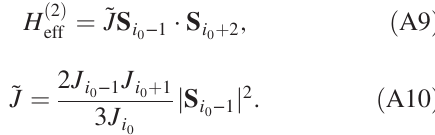
FIG. 18. Transformation of spins under the SDRG. i 0 denotes the strongest links to be removed. After the SDRG transforma- ˜ ˜ S S tion, the spins and are regenerated iff they are no i 0 − 1 i 0 þ 1 longer consistent with the rules of angular momentum